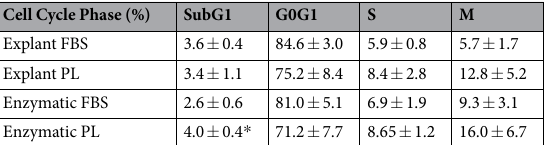
Table 2. Cell cycle studies representing the percentage of cells in phases: SubG1 phase, G0G1 phase, S phase and G2/M phase for umbilical cord tissue derived mesenchymal stem cells cultured in FBS and PL supplements. Data presented as mean percentage ± SEM of three independent experiments. Statistical comparisons were made within explant groups and within enzymatic groups. * P <